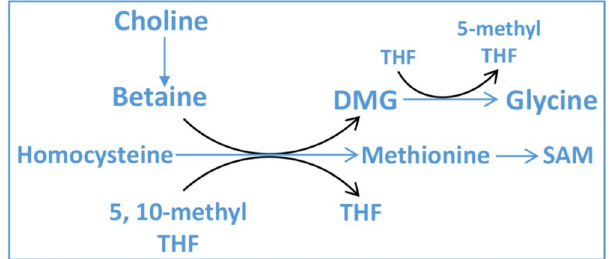
Figure 4. As a major methyl donor from diet, choline transfers its methyl-group to SAM (S-adenosyl methionine) via betaine with a concomitant formation of glycine in this process. The figure was adapted from Friesen et al . 46 . Abbreviations: THF, tetrahydrofolate; DMG, dimethylglycine.